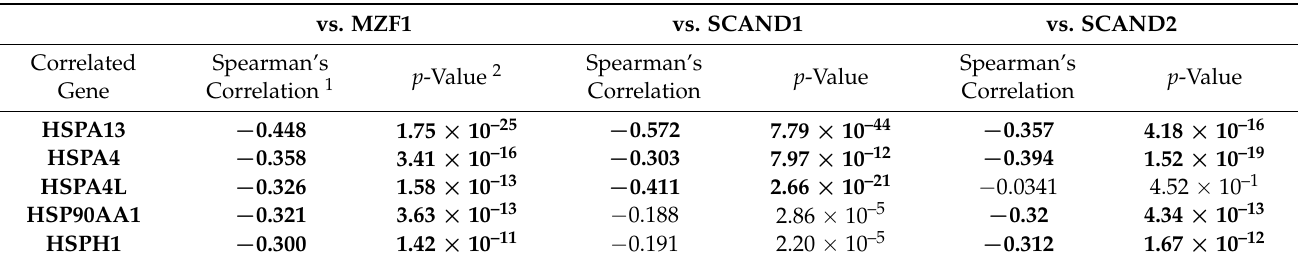
Table 6. The negative correlation of HSPs vs. MZF1, SCAND1, and SCAND2 gene expression in prostate adenocarcinoma